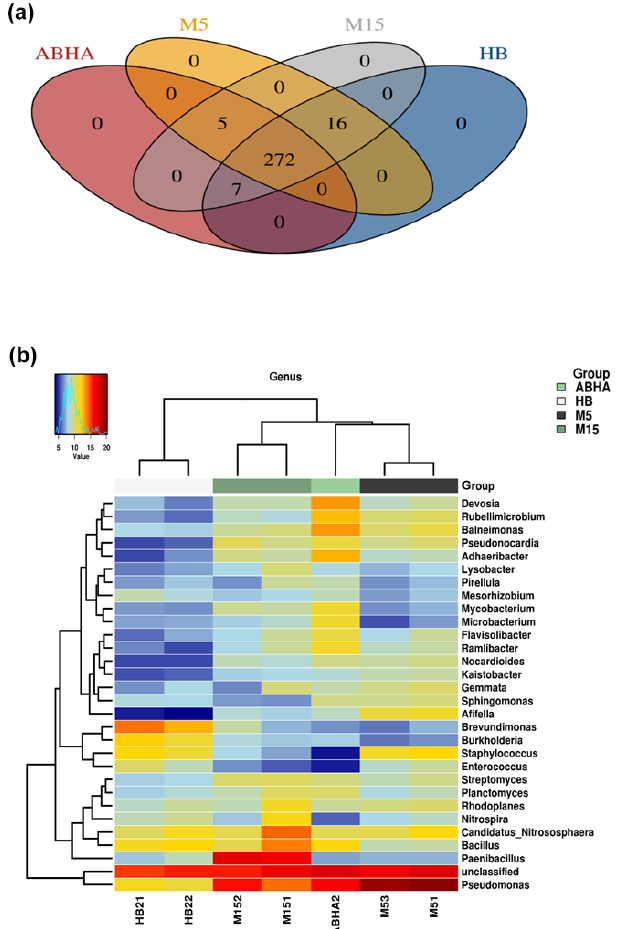
Figure 4. Venn diagram showing the number of genera present in different desert soil samples (a) . Heatmap showing the 20 most dominant genera present in the desert soil samples. M5 and M15: samples collected from Muzahmiya, HB: sample collected from Hafar Al